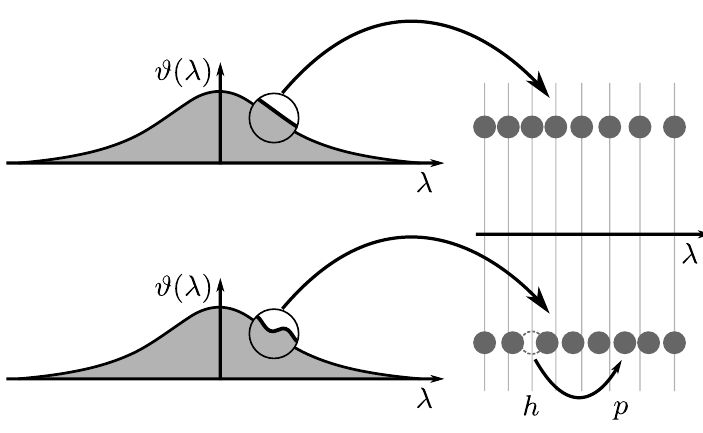
Figure 2: The filling function ϑ ( λ ) , depicted on the upper part of the figure as a function of λ , describes how densely modes with different rapidities (indicated by the sequence of circles and thin vertical lines on the right, along the rapidity axis) are populated. The filling function of an excited state depicted in the lower part of the figure is macroscopically the same as the one above. However, by zooming in the region of the particle-hole excitation, indicated by the arrow on the right, reveals both a displacement of one quasi-particle from the position it was originally occupying (dashed circle) and a small shift in the (allowed) quasi-momenta of all the other particles, as indicated by the filled circles on the right. This shift compared to the original allowed rapidities (vertical lines) is described by the back-flow function F ( λ | p , h ) and it contributes to the momentum and energy of the excited state as shown in Eqs. (11), (12) and